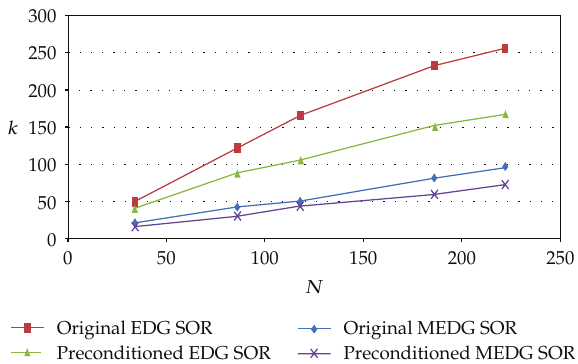
Figure 1: Number of iterations (cid:2) k (cid:3) for the four methods for di ff erent mesh sizes N .